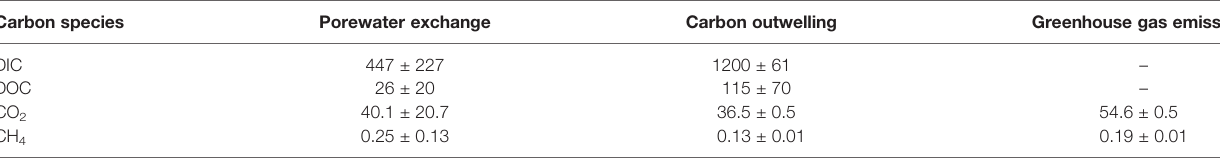
TABLE 5 | Carbon outwelling and greenhouse gas emissions (mmol m -2 d -1 ) in Andong Shoal. Carbon